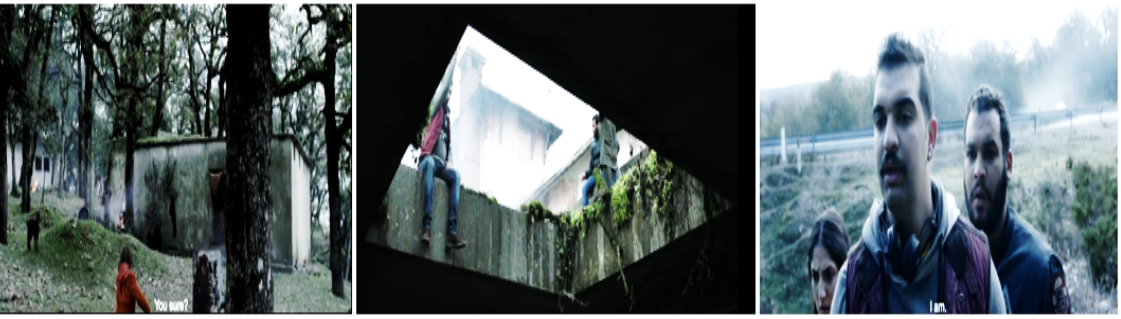
Figure 11: Choice of cloudy weather and grey skies to amplify the mystery of